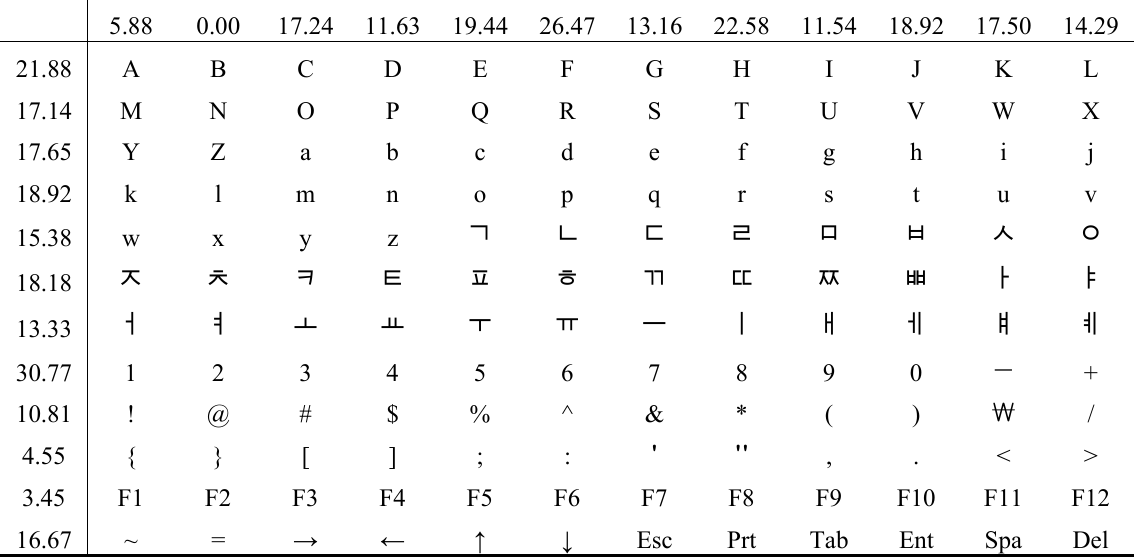
Table 3. Horizontal and vertical accuracies using only gaze-tracking (unit: